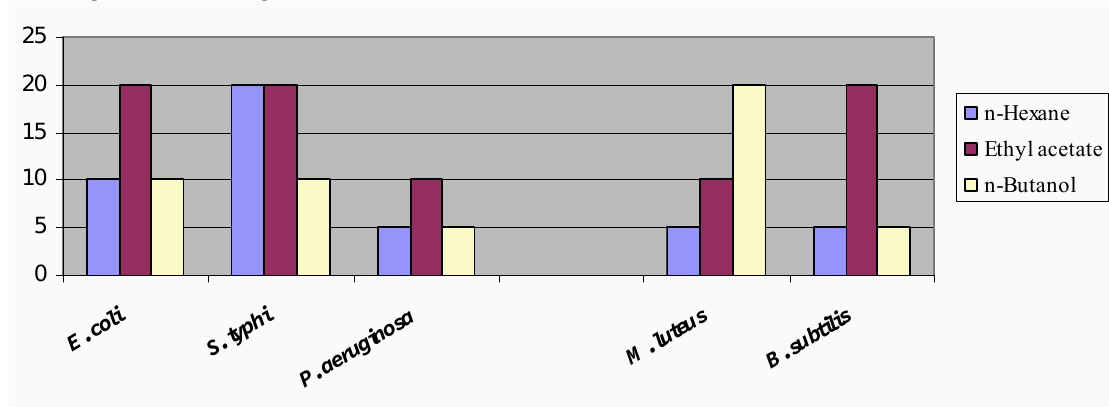
Figure 2 . Minimum Inhibitory Concentrations (mg/ml) of Different Fractions of Dodonaea viscosa against Test Organisms.